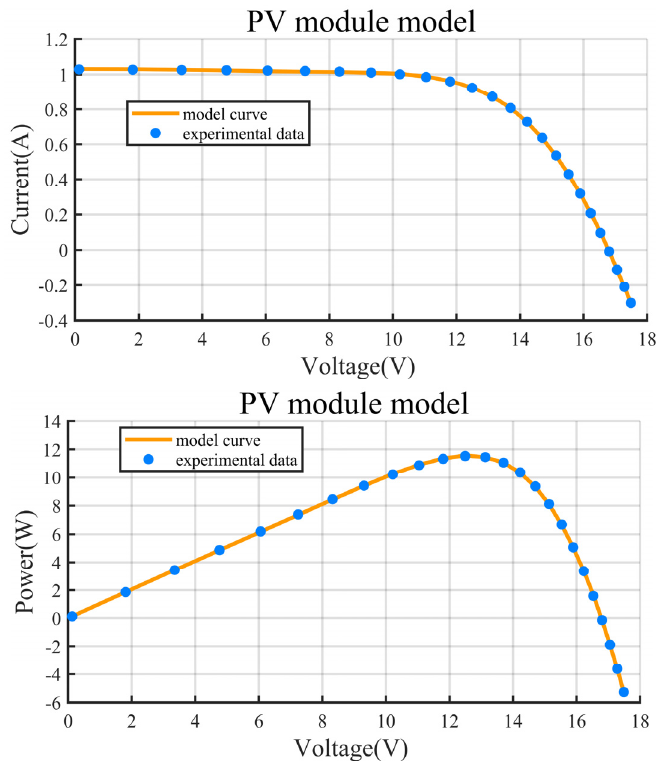
Figure A3. Comparisons between the experimental data and simulated data obtained by IMFO for PV